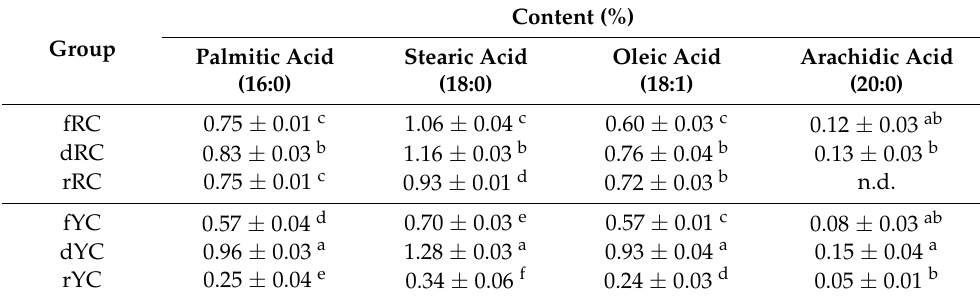
Table 2. Variation of fatty acid pattern in differently treated polymorphic cacao beans *.